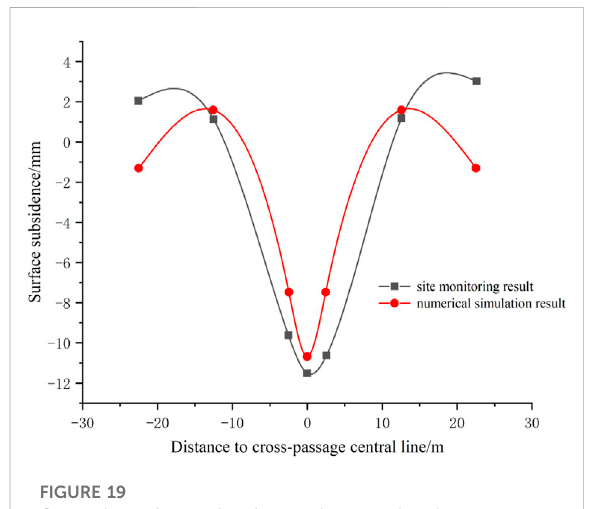
FIGURE 19 Comparison of ground surface settlement values between numerical analysis and site monitoring for Section 2.